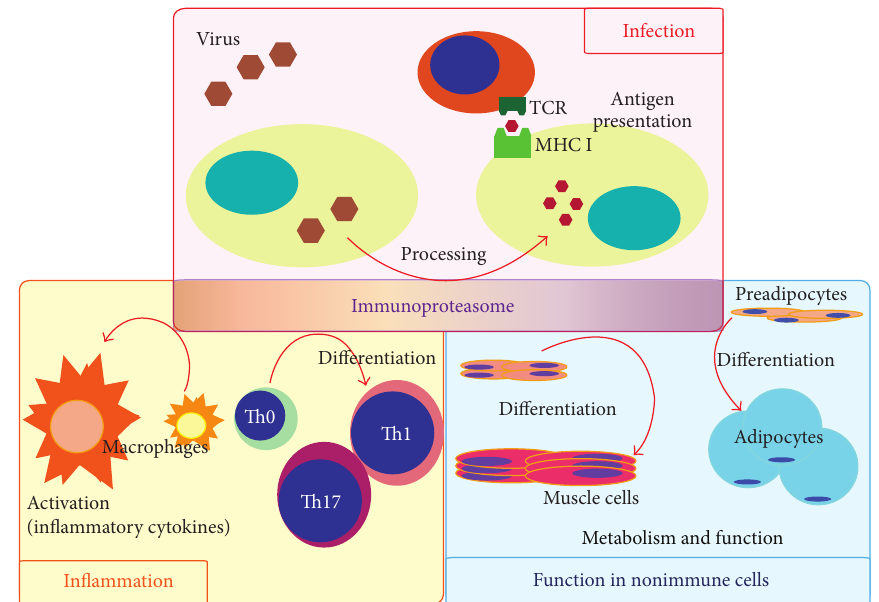
Figure 2: The immunoproteasome as a potential therapeutic target. The immunoproteasome plays an important role in immune responses, including processing viral proteins for antigen presentation, T cell differentiation, and macrophage activation. Recent studies have identified that the immunoproteasome is present in nonimmune cells, where it regulates cell differentiation and